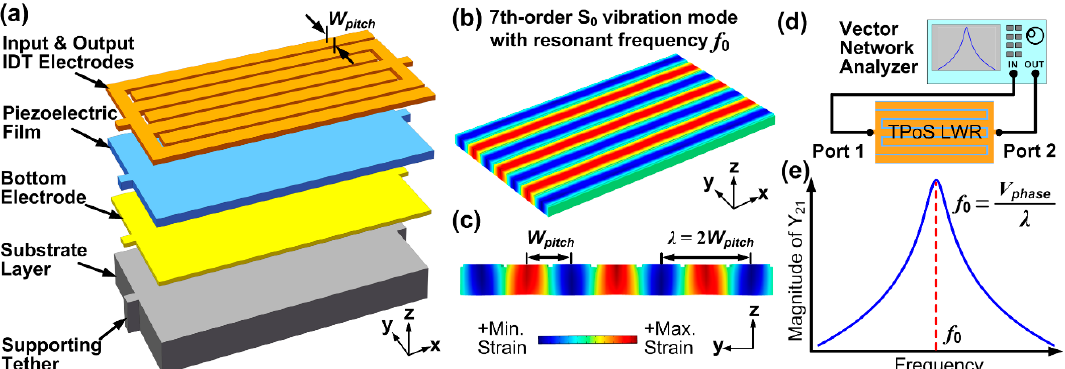
Figure 1. ( a ) Schematic for typical structure of thin-film piezoelectric-on-substrate (TPoS) resonators; ( b , c ) perspective and cross-sectional views of the vibration mode shape of 7th-order fundamental symmetrical (S 0 ) mode associated with resonant frequency f 0 ; ( d ) electrical characterization setup for a 2-port TPoS laterally vibrating resonators (LVR); ( e ) typical measured magnitude of transfer admittance Y 21 of a 2-port TPoS LVR.